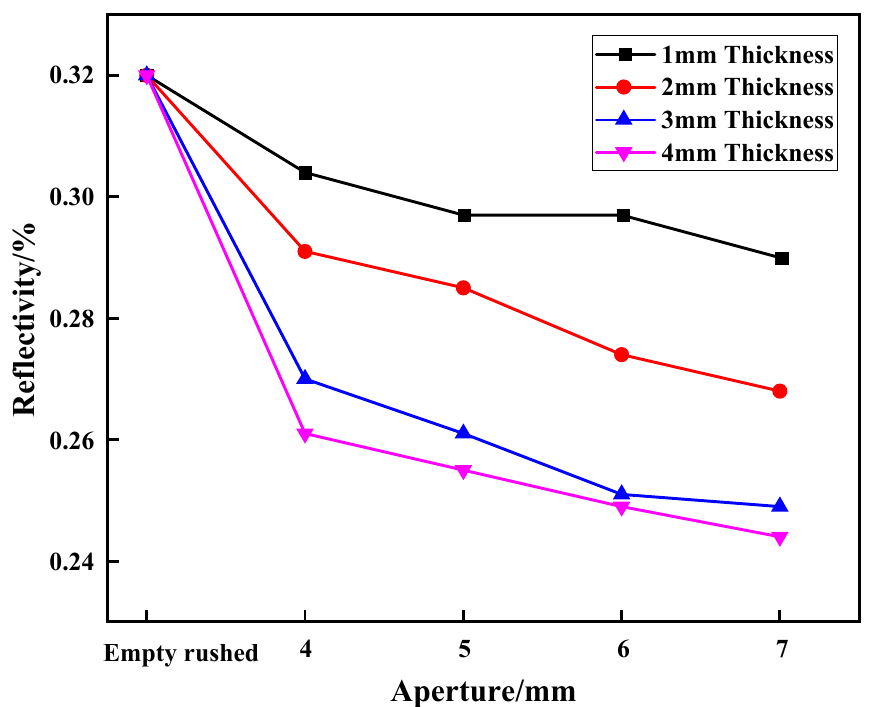
Figure 7. Variation trend of reflectivity of wave-absorbing metal plate with aperture size.